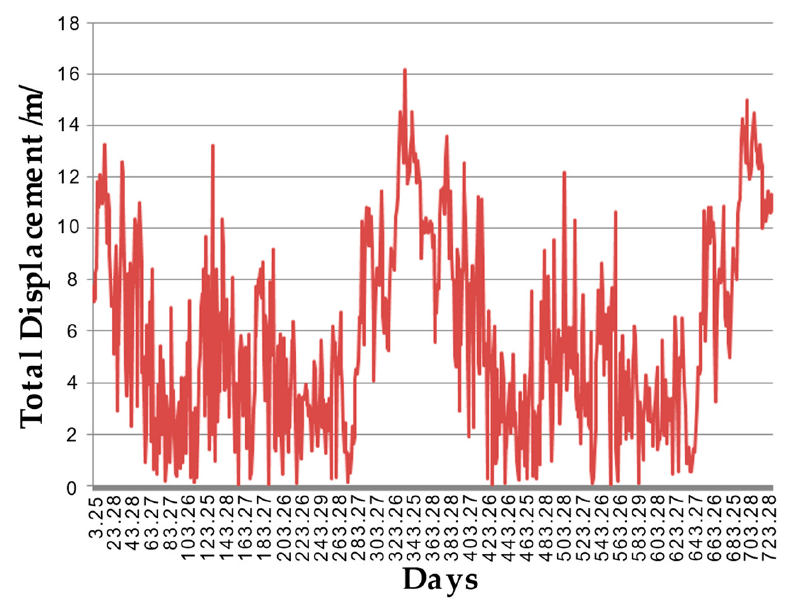
Figure 11. Plot of time dependence of total displacement /mm/ at a depth of 2812.5 m between sections 1 and 2 of Figure 3 ( φ = 0°).